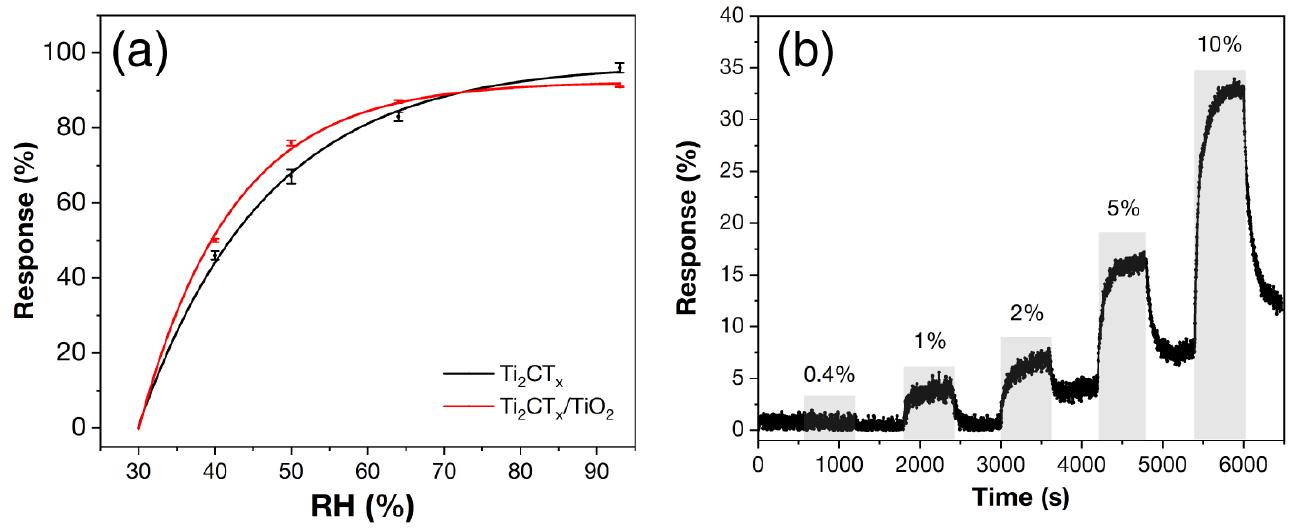
Figure 6. The responses of Ti 2 CT x and Ti 2 CT x /TiO 2 films to humidity ( a ) and Ti 2 CT x films to 0.4 – 10% O 2 at 50%RH ( b ). O 2 at 50%RH ( b